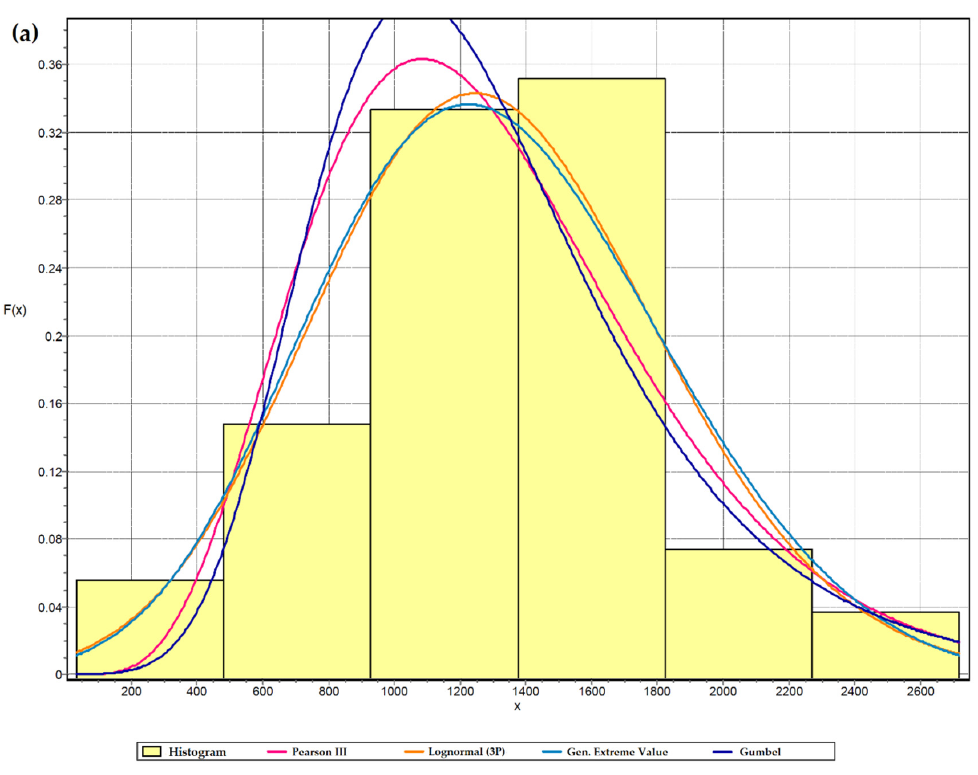
Figure 6. ( a ) Probability distribution functions (PDF) and ( b ) cumulative distribution functions (CDF) at the Vinces station.